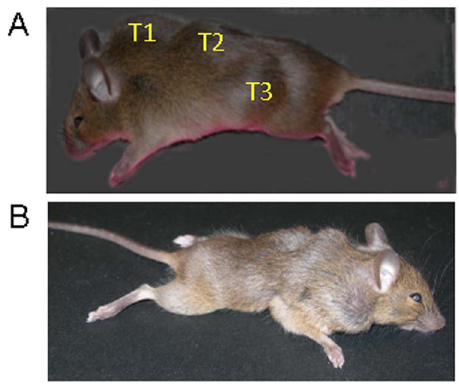
Figure 3. Multiple tumors induced in newborn CD3 epsilon mice. A . Three tumors evident in a newborn CD3 epsilon mouse that was inoculated SC with 25 m g of circular pMSV-T24-H- ras /MSV-c- myc DNA. B . Seven tumors evident in a CD3 epsilon mouse inoculated SC with 1 m g of linear pMSV-T24-H- ras /MSV-c- myc DNA; some of the tumors were not apparent until necropsy.